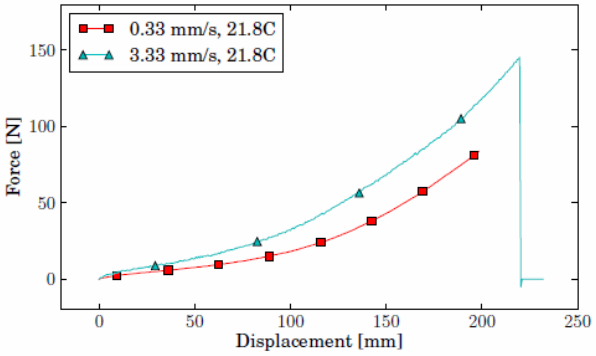
Fig. 5 Tensile test results for PVB specimens at low speeds.